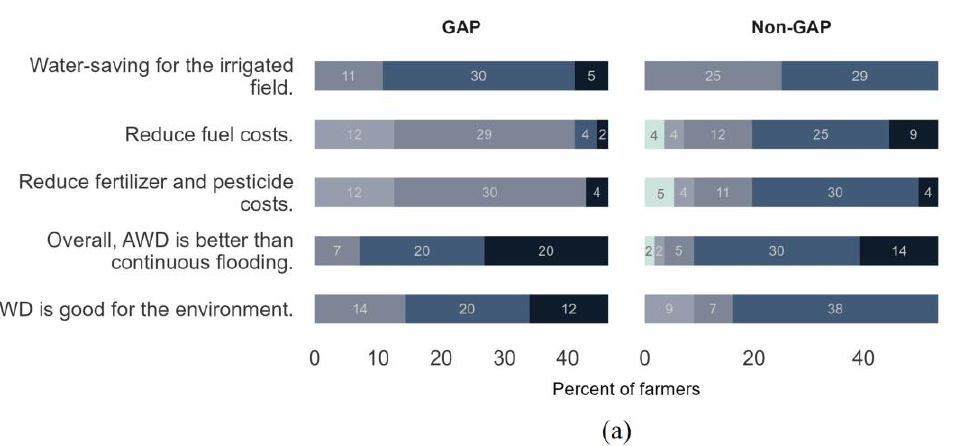
Figure 2. GAP and non- GAP farmers’ perceptions of AWD adoption intention regarding the ( a ) innovation advantages, ( b ) ease of adoption, and ( c ) trial capability . Based on mapping the cropping calendar practiced among rice farms in the study sites, Table 2 shows the difference in the cost and return of rice production between the certified and non-certified GAP farmers. The total fixed cost incurred by non-GAP farmers (702.67 THB/rai) was significantly higher than GAP farmers (528.51 THB/rai). The highest among the two groups was land rent, followed by depreciation cost, which was highly significant in non-GAP farmers. As for variable cost, there was no significant difference